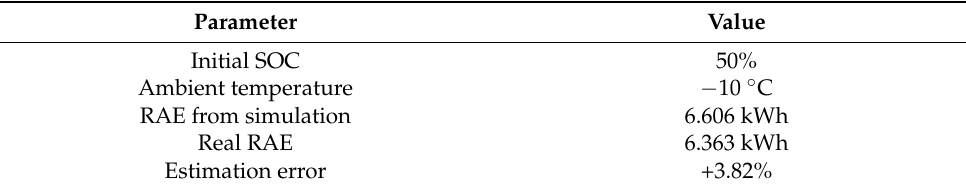
Figure 10. The calculation process of RAE. ( a ) Total process of SOC and temperature co-estimation and calculation of RAE. ( b ) Detailed flow chart of RAE calculation. Table 2. The parameters of the validation condition and